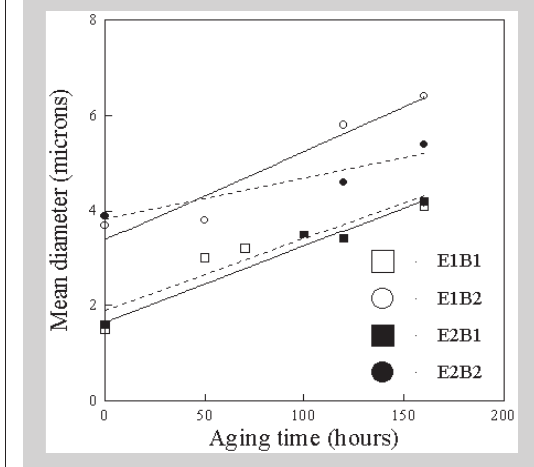
Figure 12: Mean particle diameter calculated with Eq. 7 versus aging time of oil-in-water emulsions loaded with